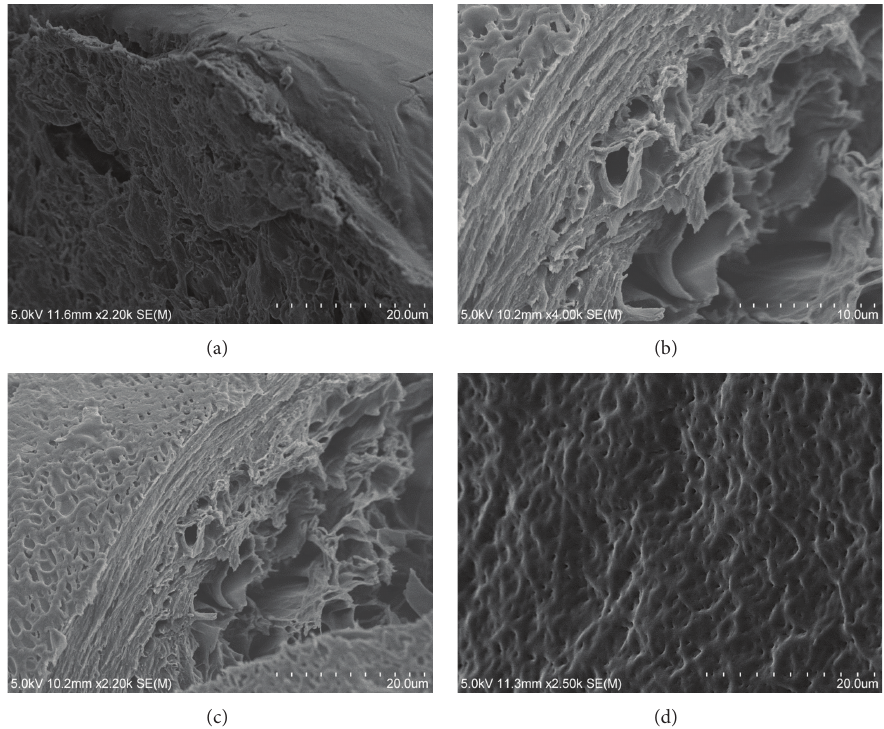
Figure 4: SEM comparisons of lyophilized irradiated samples and lyophilized nonirradiated samples. (a) Nonirradiated lyophilized sample surface and cross section. (b-c) Irradiated lyophilized sample cross sections at two different magnifications. (d) Irradiated lyophilized sample